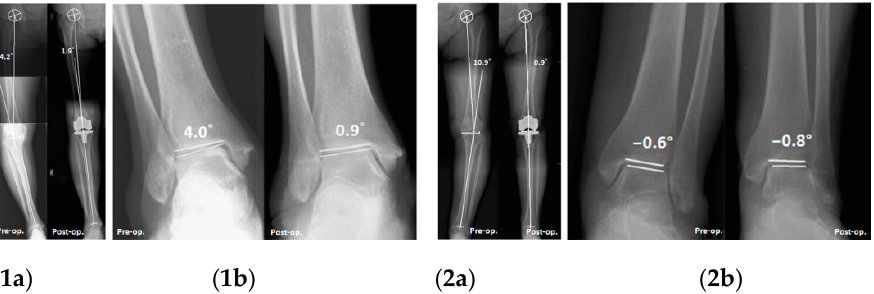
Figure 3. Ankle alignment changes after TKA in different preexisting ankle deformities. (1) Preexisting varus ankle deformity: ( 1a ) HKA: 14.2 to 1.9°; ( 1b ) PTA: 4.0 to 0.9°. (2) Preexisting valgus ankle deformity: ( 2a ) HKA: 10.9 to 0.1°; ( 2b ) PTA: − 0.6 to − 0.8°.